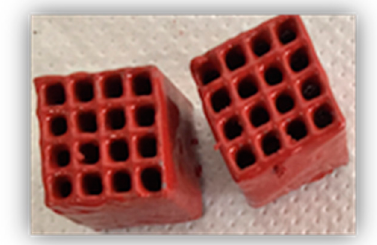
Figure 5. Ceramic monolithic filter (200 cpsi) coated with a silicone-based coating containing tethered Econea (<0.6 wt. %).